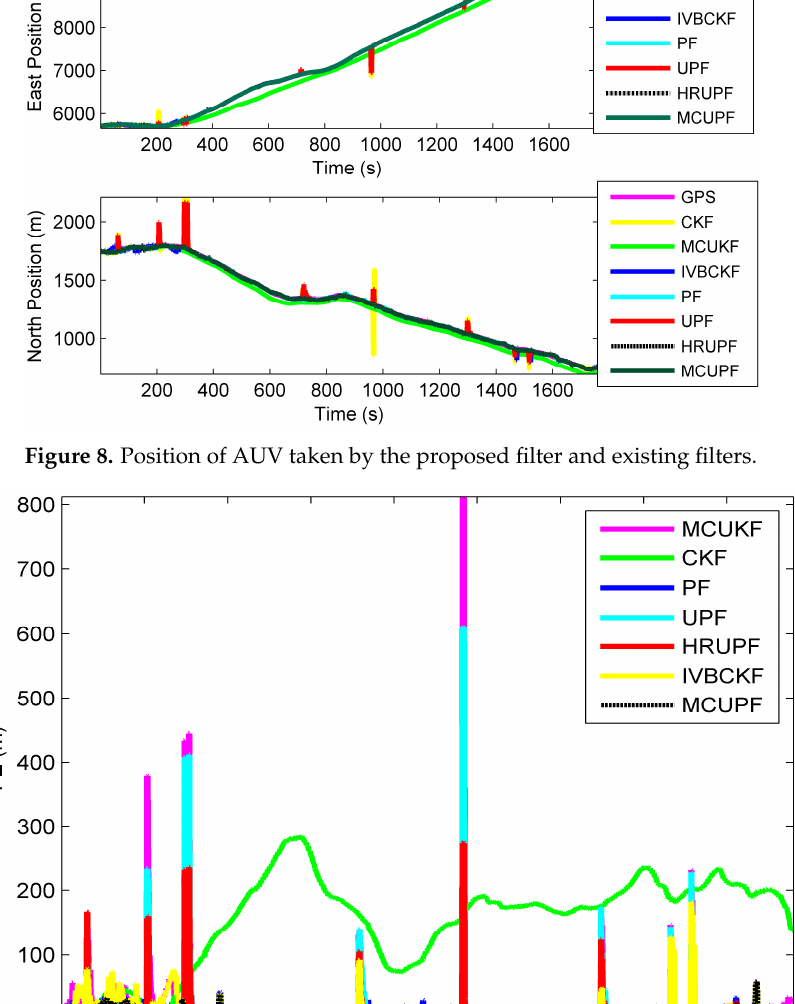
Figure 9. Position errors (PEs) of the proposed filter and existing filters in cooperative navigation (CN) of AUVs. Table 6. Parameters of employed filters.